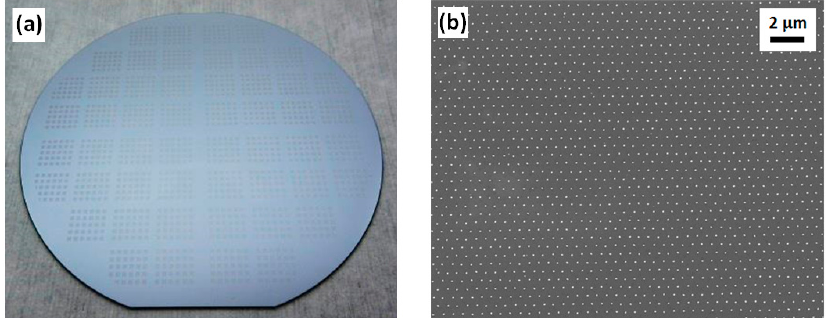
Figure 2. Images of a four-inch Si stamp after electron-beam lithography (EBL), DRIE, and removal of resist: ( a ) Image of the Si stamp taken by camera. ( b ) Top-view scanning electron microscopy (SEM) image of the Si nanopillars related to the exposure dose of 40 µC/cm 2 .